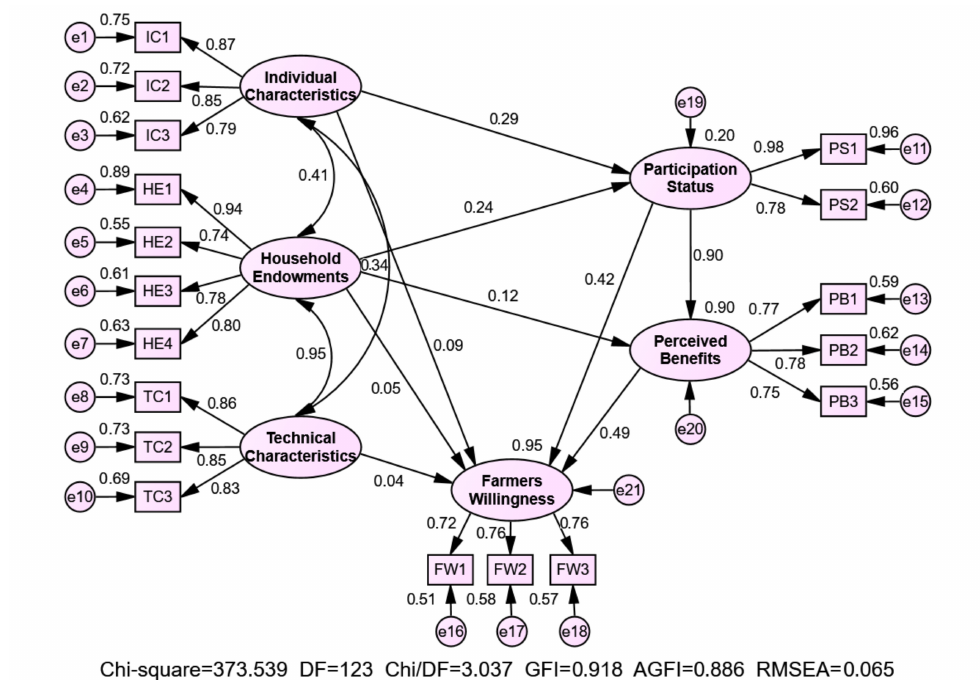
Figure 5. SEM of farmers’ willingness to participate in soil remediation. Note: From the unstandard- ized regression weights, there were only two insignificant paths ( p > 0.05): household endowments to farmers’ willingness and technology characteristics to farmers’ willingness. The reliability analysis and validity tests of the model are presented in Supplementary Tables